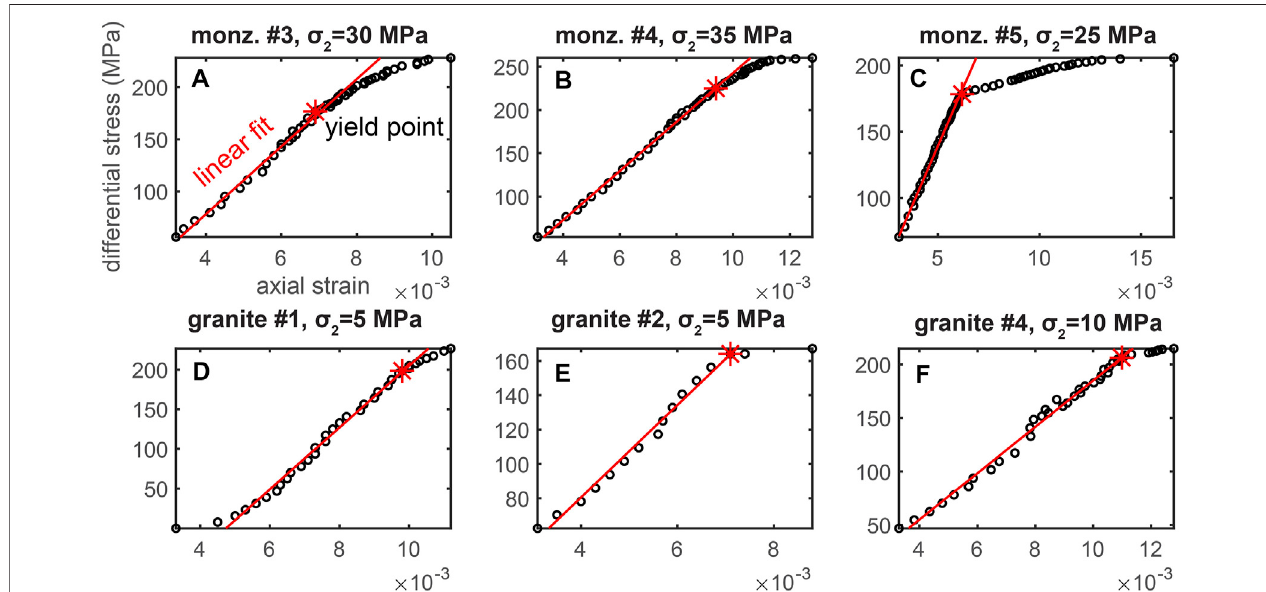
FIGURE2| Differentialstressversusaxial strain relationships forthe sixexamined experiments: (A) monzonite #3, (B) monzonite#4, (C) monzonite #5, (D) granite #1, (E) granite #2, and (F) granite #4. Black circles show the conditions when an X-ray tomogram was acquired. Red lines show the linear fi t of the early portion of the data. Red stars show the identi fi ed yield point, when the data diverges from the linear fi t. The title of each plot shows the experiment abbreviation ( Table 1 ), and applied con fi ning stress, σ 2 . In experiment monz. #4, we applied a pore fl uid pressure, p (cid:2) 5